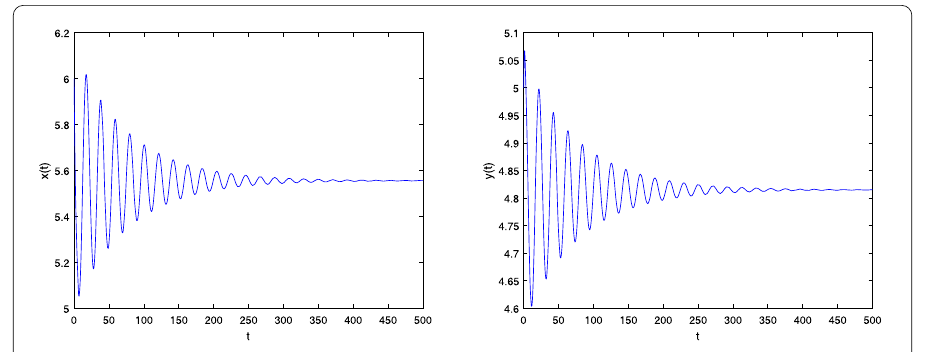
Figure 1 Waveform plots of system (2.2) with initial values (6.46,5.1) in Example 1. The delay is chosen as: τ = 3.8 < τ 0 = 4.9967. This figure illustrates that the coexistence equilibrium ε 2 = (5.5556,4.8148) is asymptotically stable